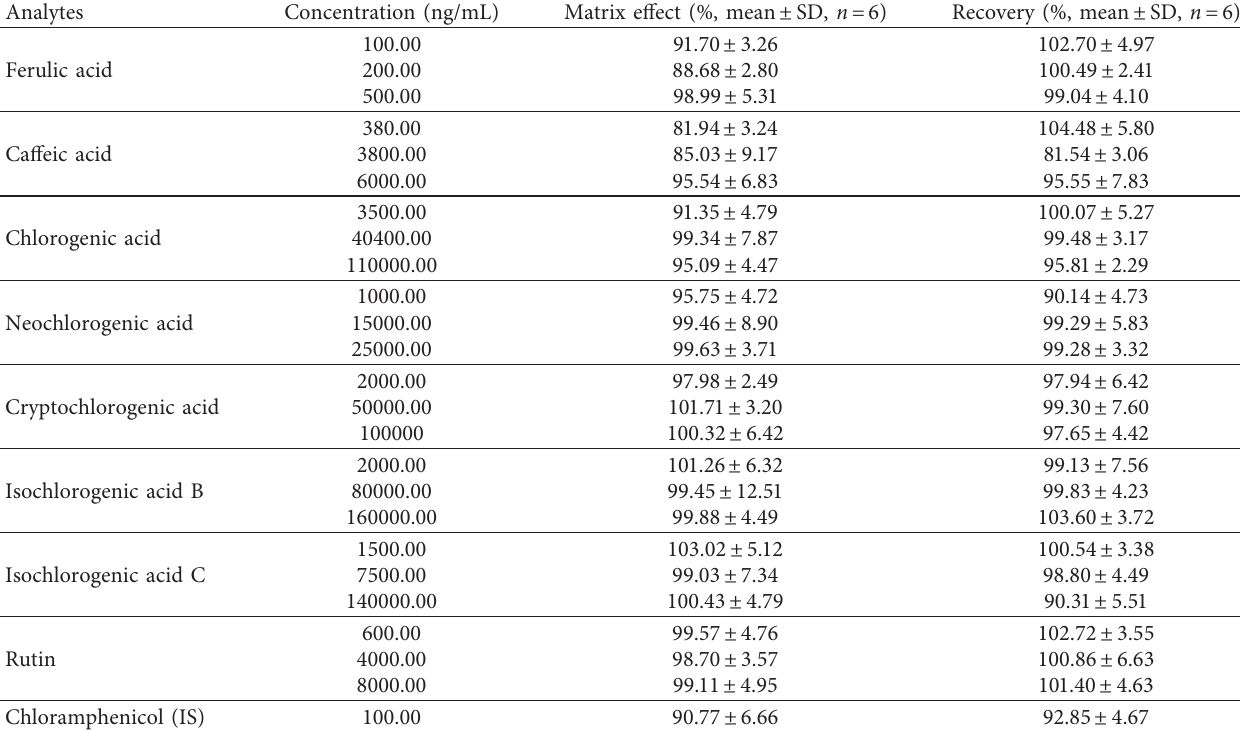
Table 4: Matrix effects and extraction recoveries for the analytes in rat plasma.